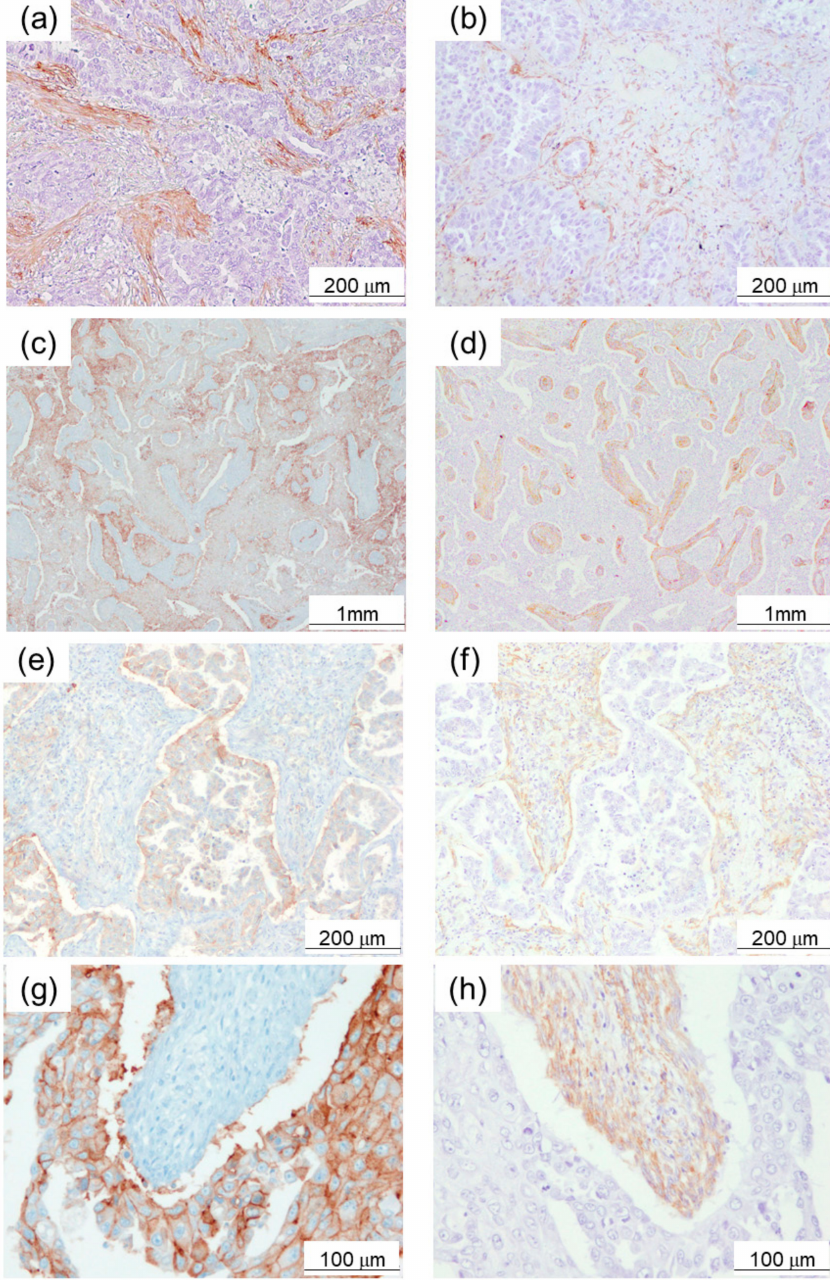
Figure 1. Expression of α -smooth muscle actin ( α -SMA) in lung adenocarcinoma tissue samples. ( a ) High expression example ( ≥ 60%). ( b ) Low expression example ( < 60%). ( c ), ( e ), ( g ) Programmed death ligand 1 (PD-L1), and ( d ), ( f ), ( h ) α -SMA immunoreactivity in serial tissue sections of mirror images of lung adenocarcinoma. High PD-L1 immunoreactivity was detected in adenocarcinoma cells adjacent to α -SMA-positive